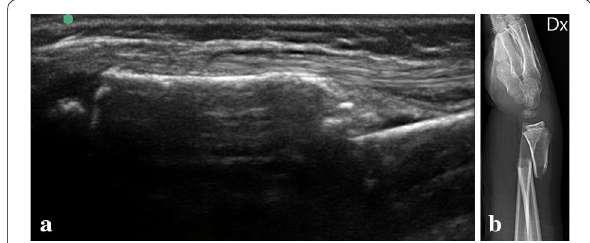
Fig. 1 a Displaced complete fracture of the distal radius. US dorsal longitudinal view. b (Same case as image a ) Radiograph lateral view. Displaced complete fracture of the distal radius